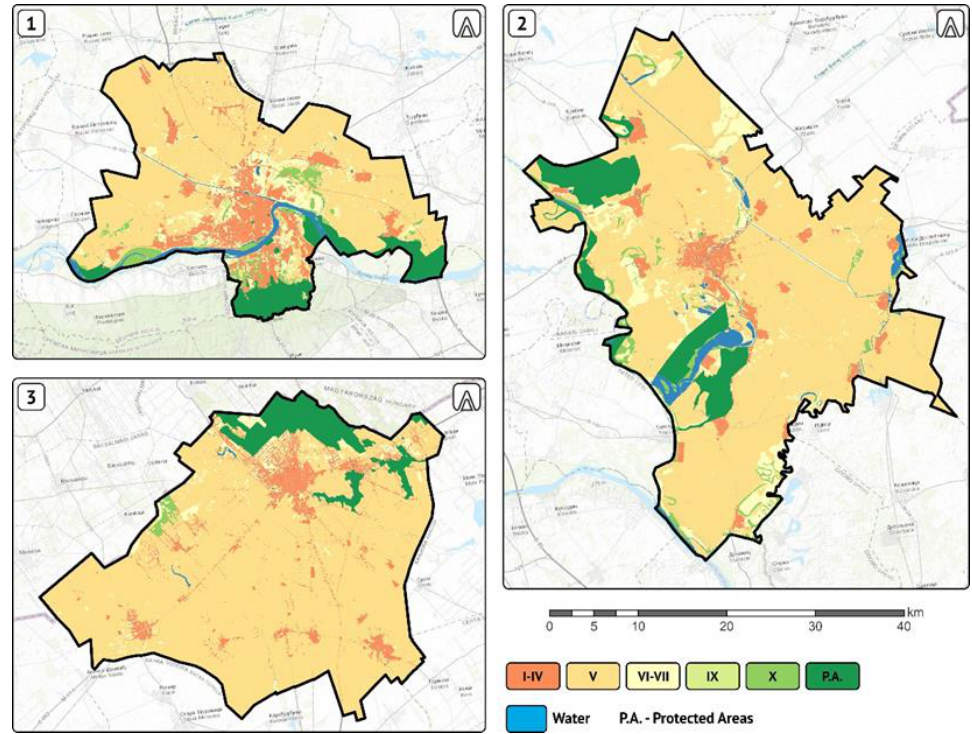
Figure 4. The Novel Urban Ecosystems/Landscapes applied in the territories of ( 1 ) Municipality of Novi Sad; ( 2 ) Municipality of Zrenjanin; ( 3 ) Municipality of Subotica. A detailed legend is presented in Figure 2c (NUE). Table 3. Application of the Grey-Green Continuum and the Novel Urban Ecosystems/Landscapes concepts.